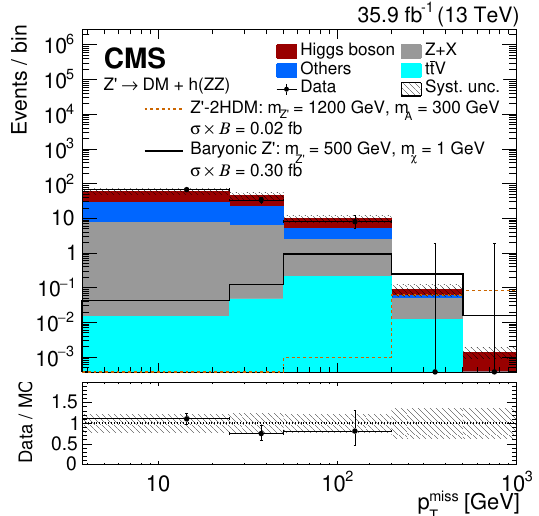
Figure 6 . The p miss distribution for the expected background and observed events in data in the T h ZZ analysis. Two signal benchmarks, corresponding to the Z 0 -2HDM (dotted orange line, left) ! and baryonic Z 0 (solid black line, right) model are superimposed. The signal is normalized to the product of cross section and , where represents the h ZZ branching fraction. The systematic B B ! uncertainties are shown by the hatched band. The ratios of the data and the sum of all the SM backgrounds are shown in the bottom